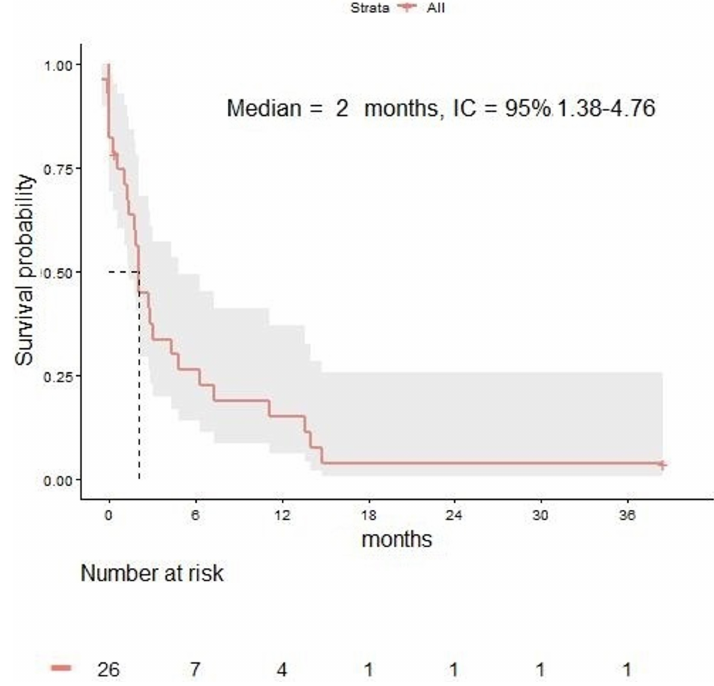
Figure 3. Progression-free survival in melanoma patients with leptomeningeal